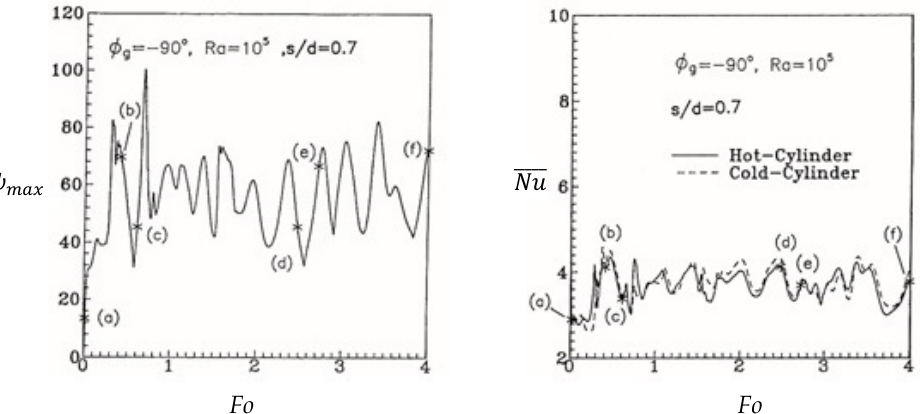
Figure 5. Variations in the maximum stream function ( left ) and average Nusselt number ( right ) of the cold and hot cylinders versus time ( φ g = − 90 ◦ , Ra = 10 5 and s / d = 0.7).